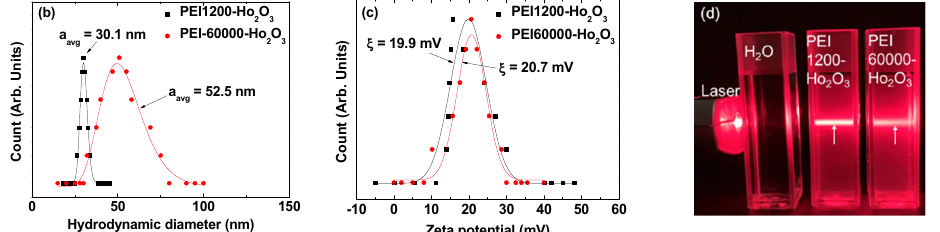
Figure 3. ( a ) Images of PEI1200- and PEI60000-coated ultrasmall Ho 2 O 3 nanoparticles in aqueous media (vials on the left and right-side, respectively) with a concentration of ~30 mM Ho. ( b ) DLS patterns of PEI1200- and PEI60000-coated ultrasmall Ho 2 O 3 nanoparticles in aqueous media with log-normal function fits to the observed DLS patterns to estimate d avg . ( c ) The zeta potential curves of PEI1200- and PEI60000-coated ultrasmall Ho 2 O 3 nanoparticles in aqueous media. ( d ) Tyndall effect (or light scattering by the nanoparticle colloids) of PEI1200- and PEI60000-coated ultrasmall Ho 2 O 3 nanoparticles in aqueous media (samples on the middle and right-side, respectively), establishing the colloidal dispersion of PEI-coated nanoparticles in aqueous media; no such light scattering is observed in triple-distilled water (sample on the left). Arrows show laser light scattering by nanoparticle colloids.